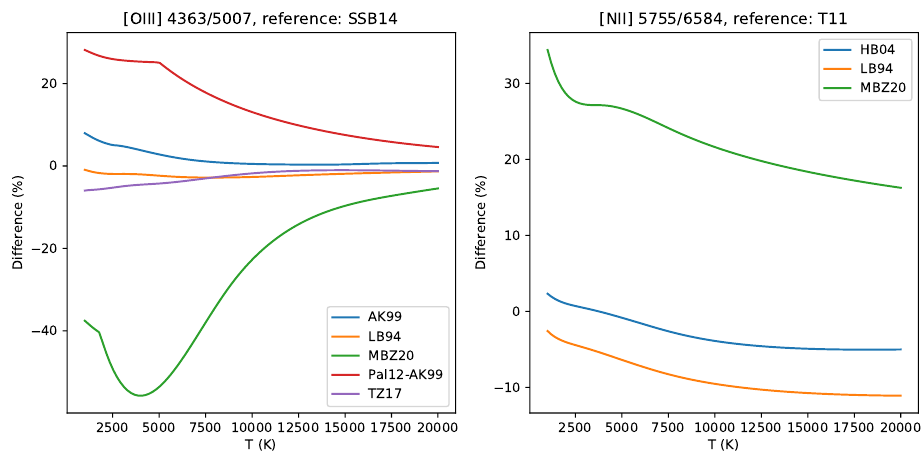
Figure 7. Comparison of the temperature-sensitive emissivity ratios of [O III ] 4363/5007 (left panel) and [N II ] 5755/6584 (right panel) computed at n e = 10 3 cm − 3 . For [O III ], we compare the ratios obtained when using the SSB14 default ECS [63] with other datasets; for [N II ], the default ECS are T11 [59]. Data provenance is: LB94 [57]; AK99 [60]; HB04 [58]; Pal12 [61]; TZ17 [62]; and MBZ20 [56].